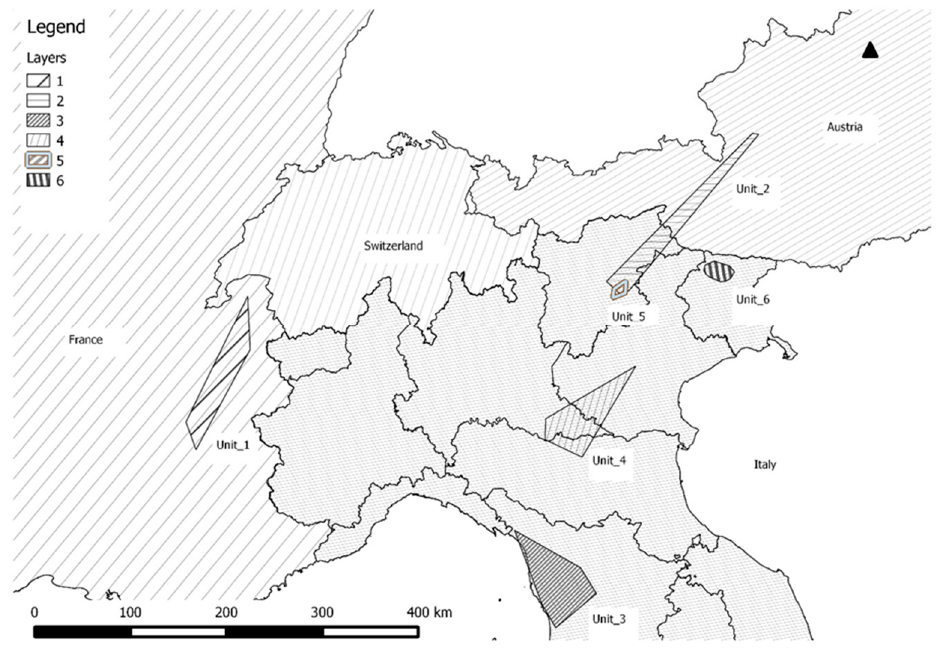
Figure 2. Work area (i.e., home range) explored by the machines during this study (notes: polygons represent the area explored by each study unit, as reported in the legend near each individual polygon).